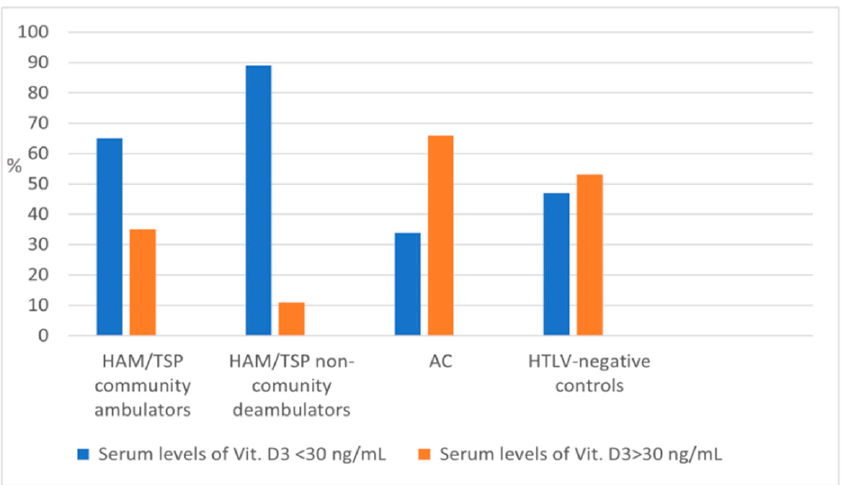
Figure 1. Proportion (%) of subjects with normal/abnormal vitamin D levels according to HTLV status and ambulation capacity.